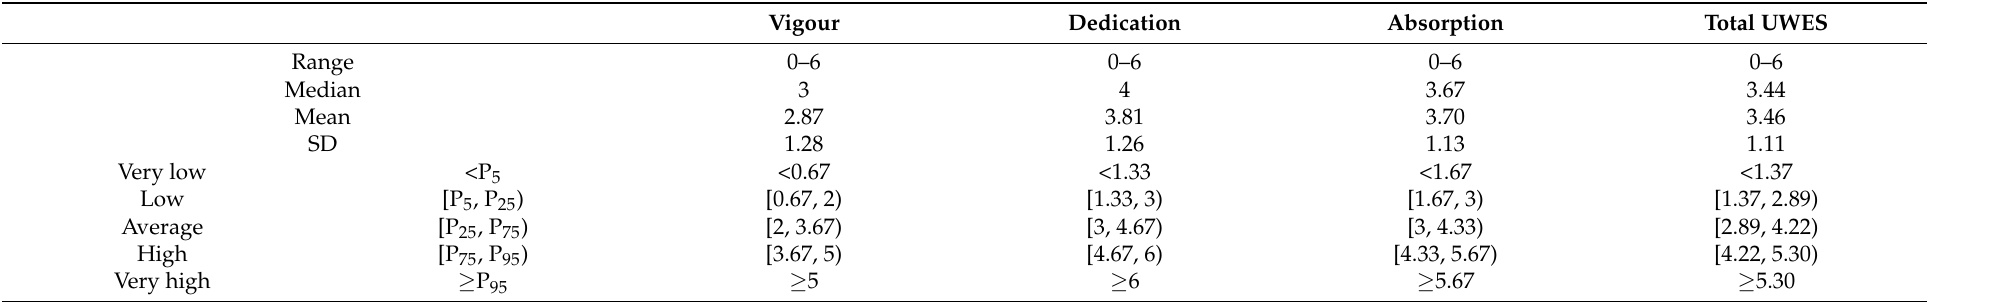
Table 2. Dimensions and total score UWES-9 (N =